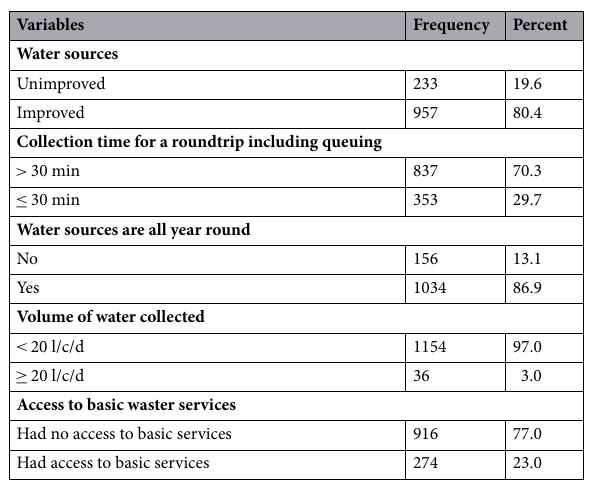
Table 2. Access to basic water services among households (n = 1190) in a rural setting of northwest Ethiopia, May 2016. l/c/d liters per capita per day.